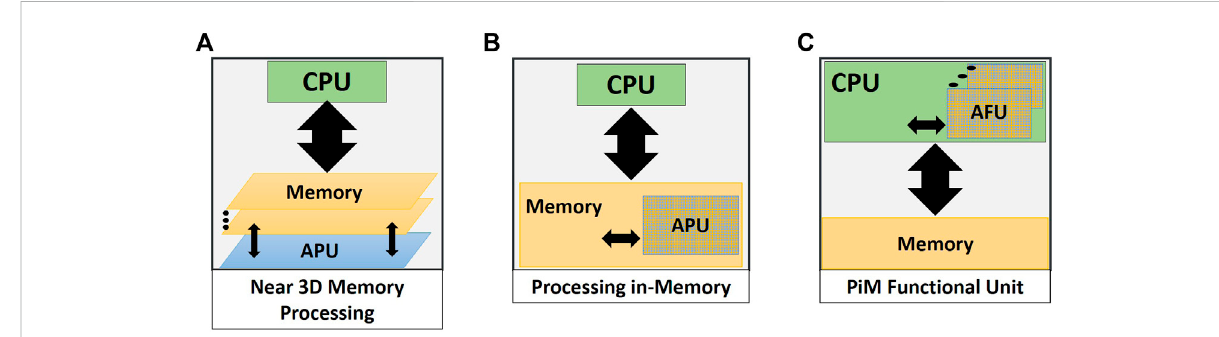
FIGURE 2 Different processing-in-memory hardware architectures for accelerating AI applications. (A) Near 3D memory processing solutions embed AI processing functionality into the base logic die of 3D stacked memory. (B) Processing-in-memory solutions convert a part of the memory hierarchy (SRAM, DRAM or NVM) into a dedicated AI Processing Unit (APU). (C) AI-PiM tightly integrates optimum sized PiM accelerators as AI Functional Units (AFU) inside the processor